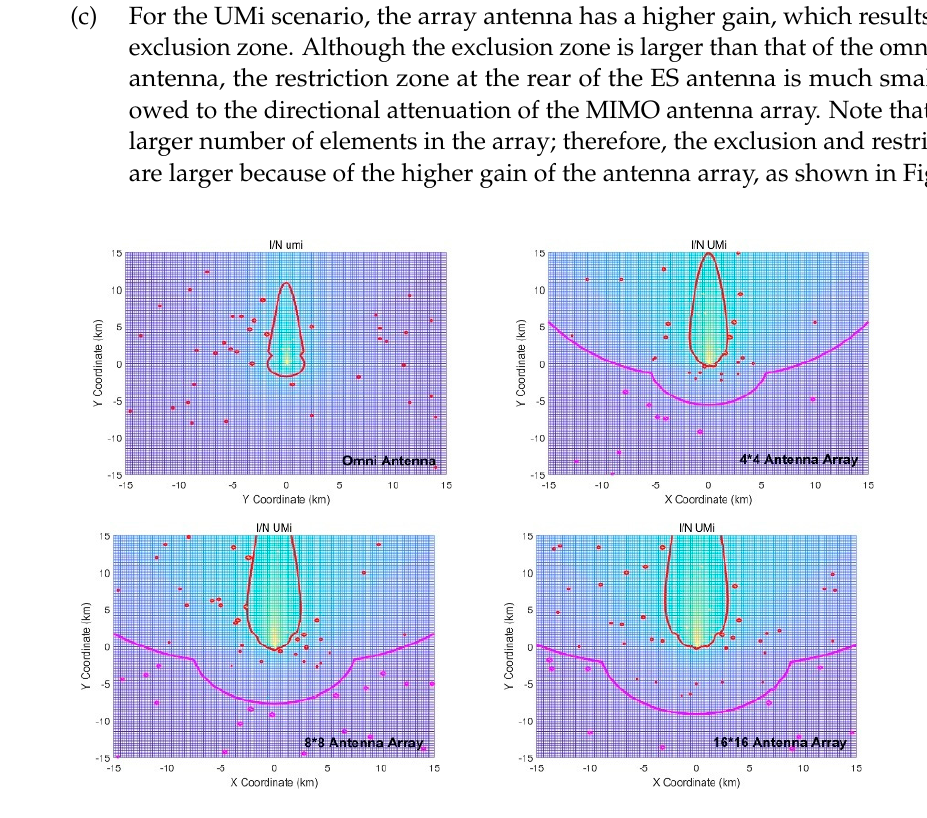
Figure 30. Sizes of the exclusion and restriction zones for UMi.